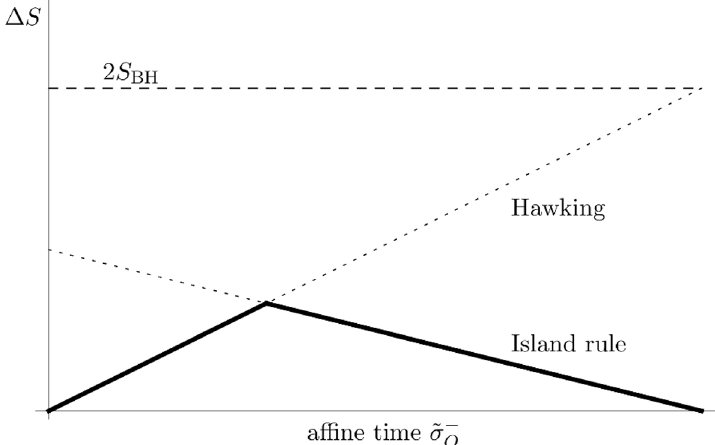
Figure 5 . Page curve (assuming a large initial mass M (cid:29)